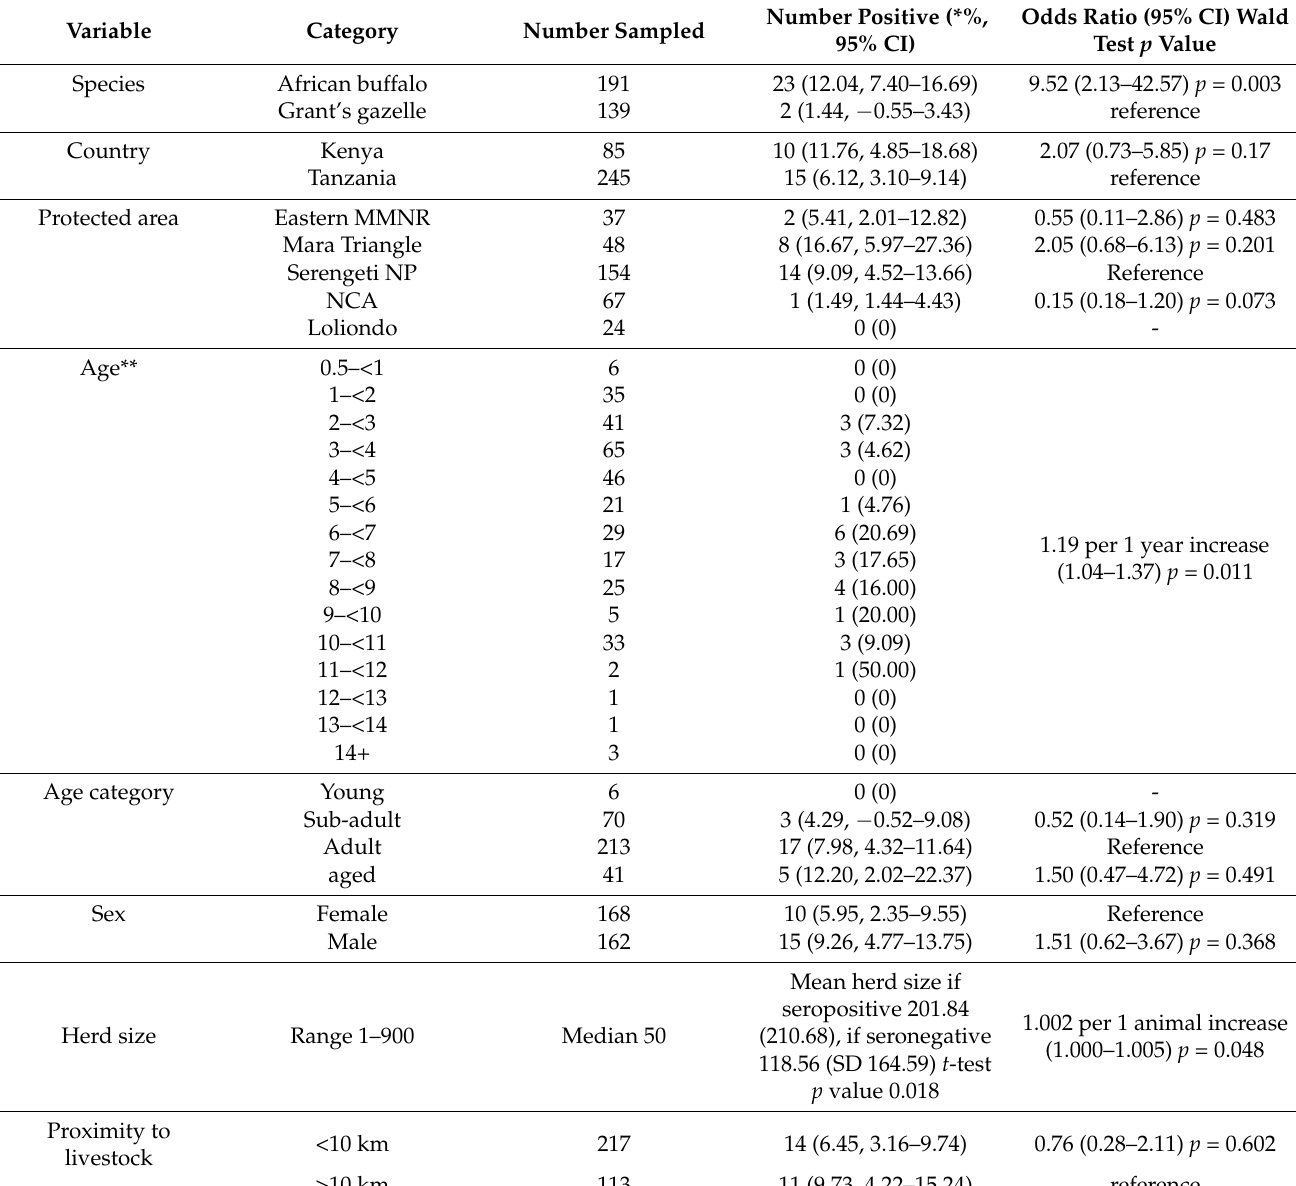
Table 5. Peste des petits ruminants virus antibody competitive enzyme-linked immunosorbent assay results for 191 African buffalo and 139 Grant’s gazelle (percentage inhibition <50 = positive) and univariable analysis (mixed-effect logistic regression with site as random effect) (n =